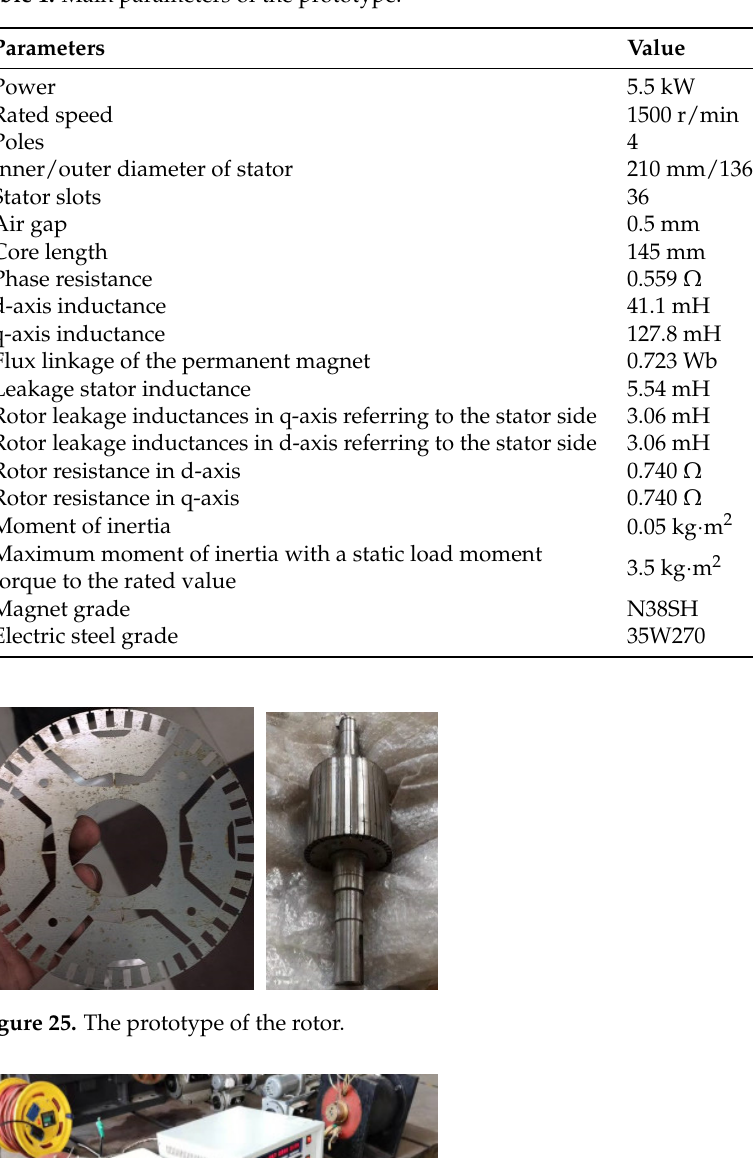
Table 1. Main parameters of the prototype.